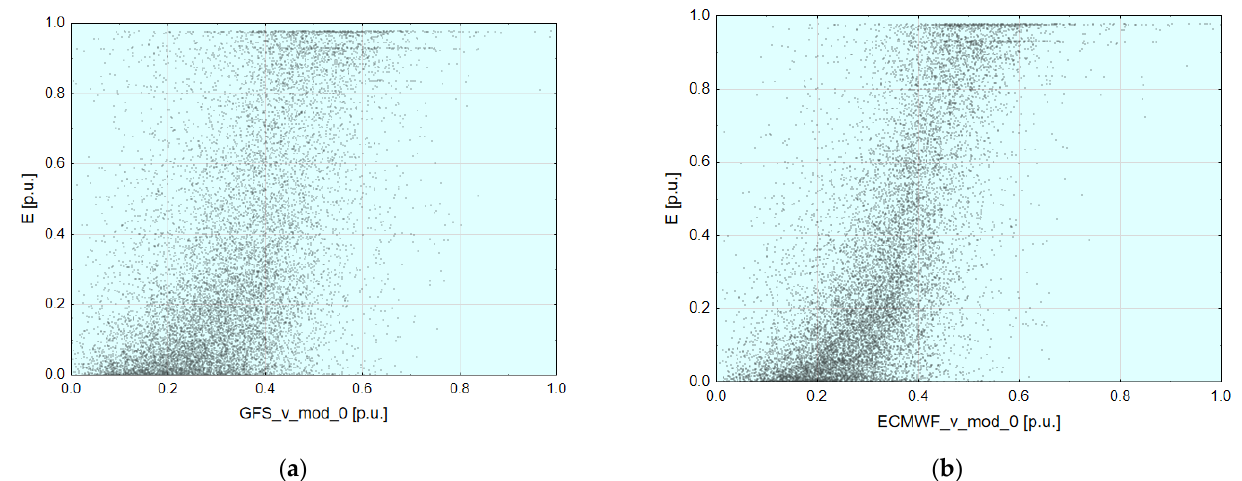
Figure 7. ( a ) Relationship between wind speed forecast from GFS NWP model and electricity gen- eration from Wind Farm B; ( b ) Relationship between wind speed forecast from ECMWF NWP model and electricity generation from Wind Farm B.